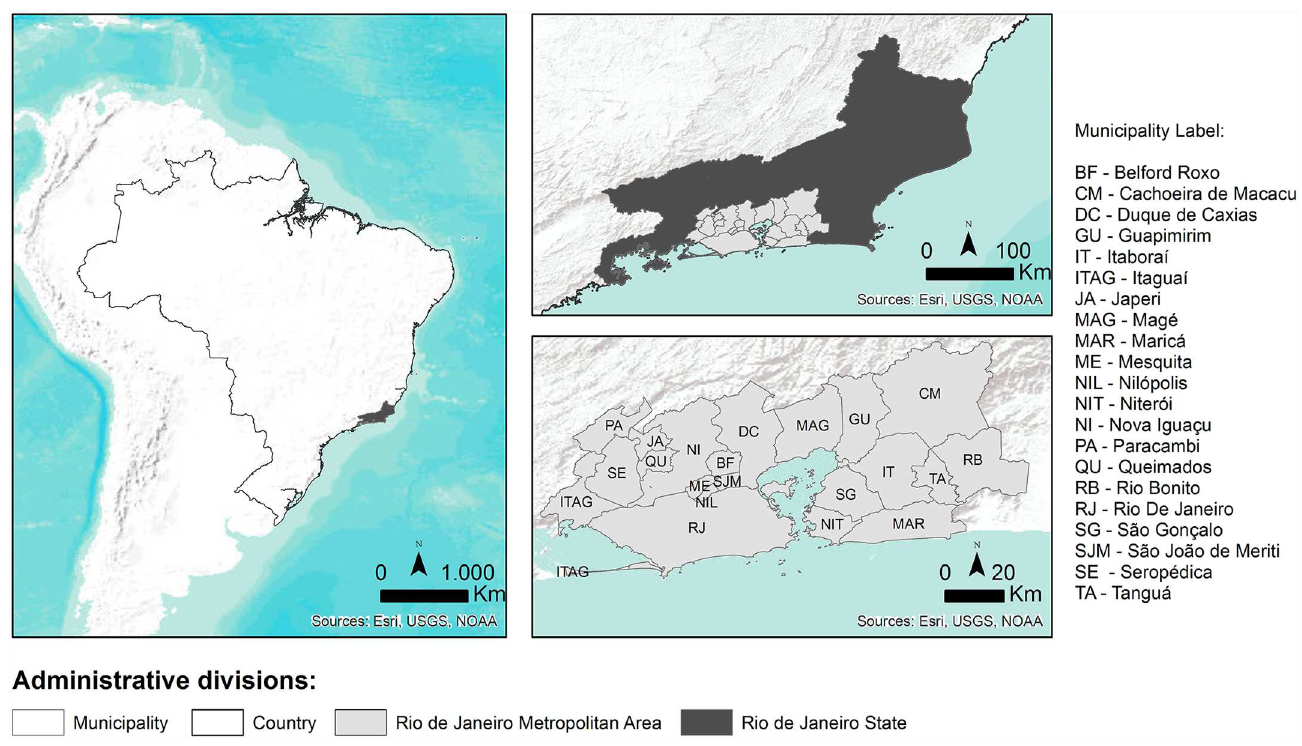
Fig 1. Localization of the metropolitan region of Rio de Janeiro state,